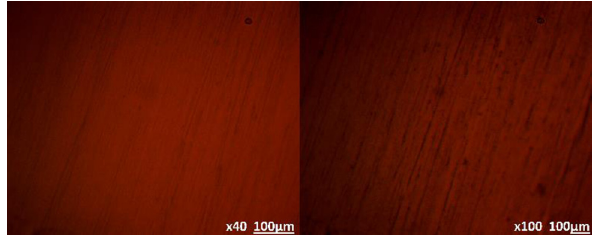
Figure 4: Optical representative images for B265TiN, B265TiQ, and B265TiA alloy before corrosion test.